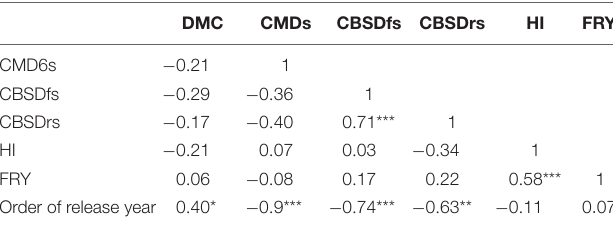
TABLE 5 | Pearson’s correlation coefficients among selected cassava traits evaluated in cassava varieties released between 1940 and 2019 in Uganda.